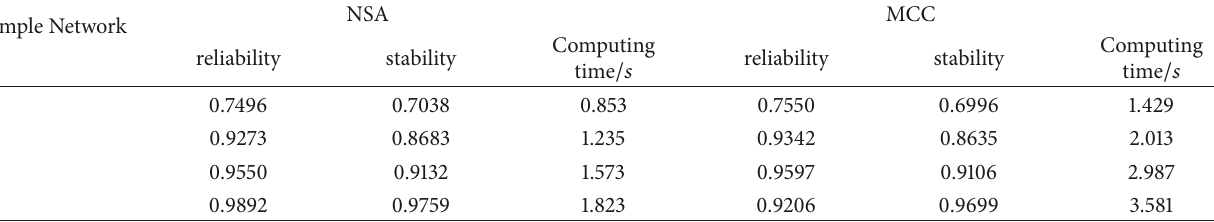
Table 2: Comparative experiment.